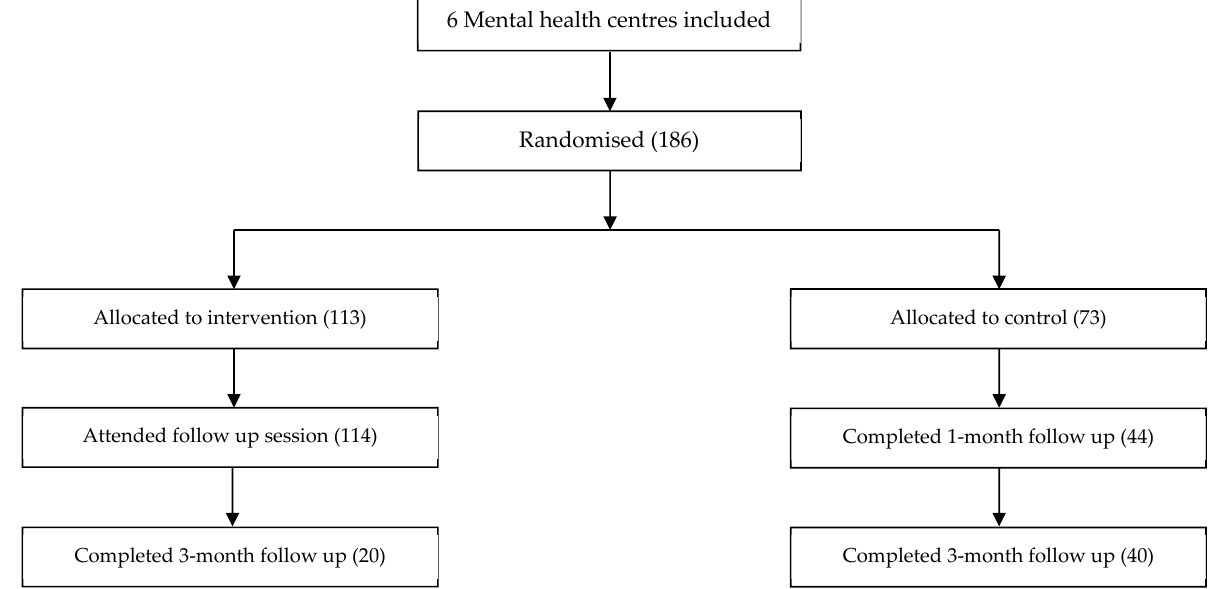
Figure 4. Flow diagram of the mental health centres recruitment and follow-up process.